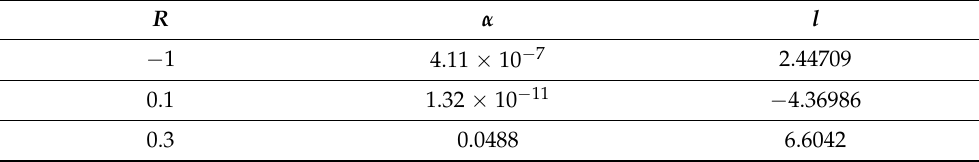
Table 6. The values of α and l at different stress